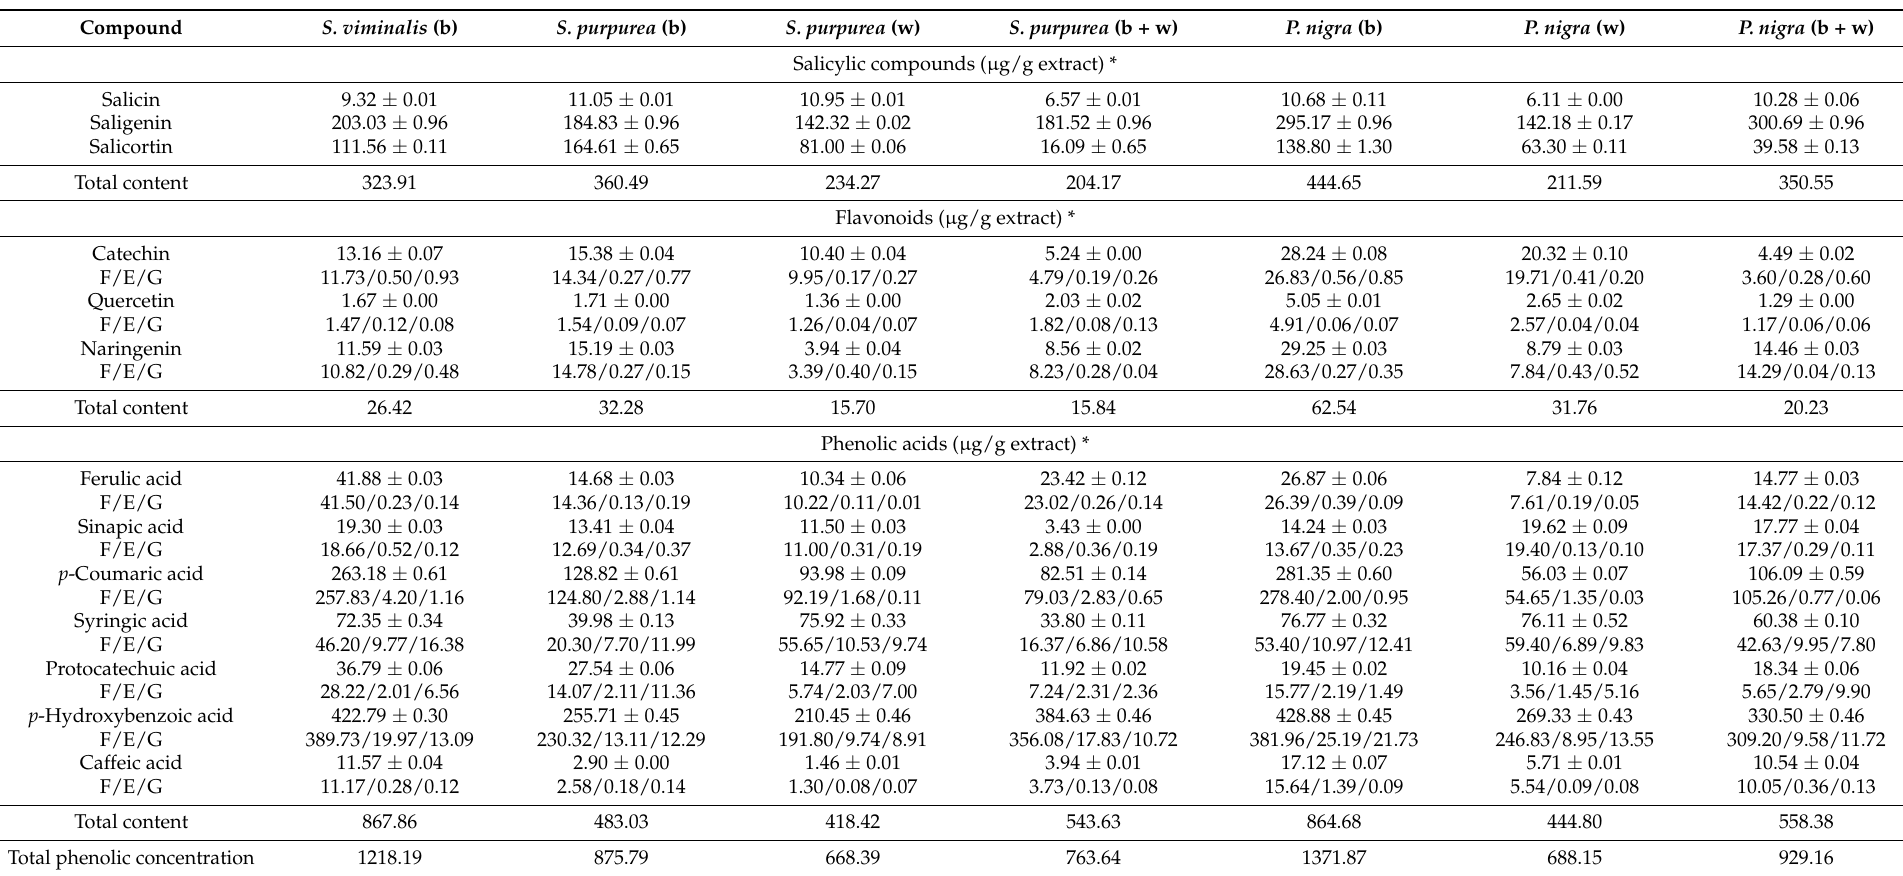
Table 4. Influence of substrate on salicylic compounds, flavonoids and phenolic acids concentration in extracts obtained with scCO 2 and water.